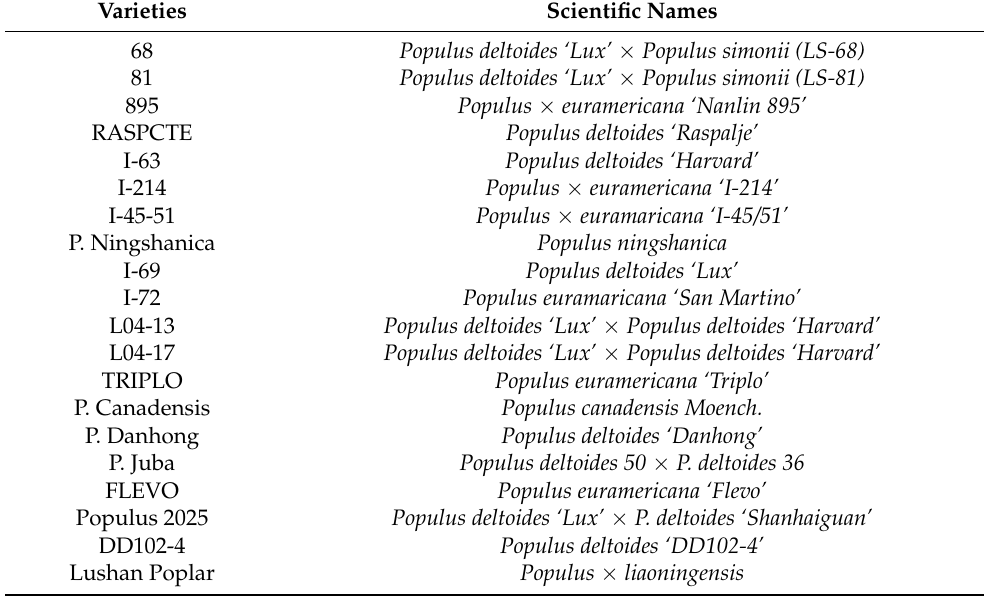
Table 1. Scientific names of 20 poplar